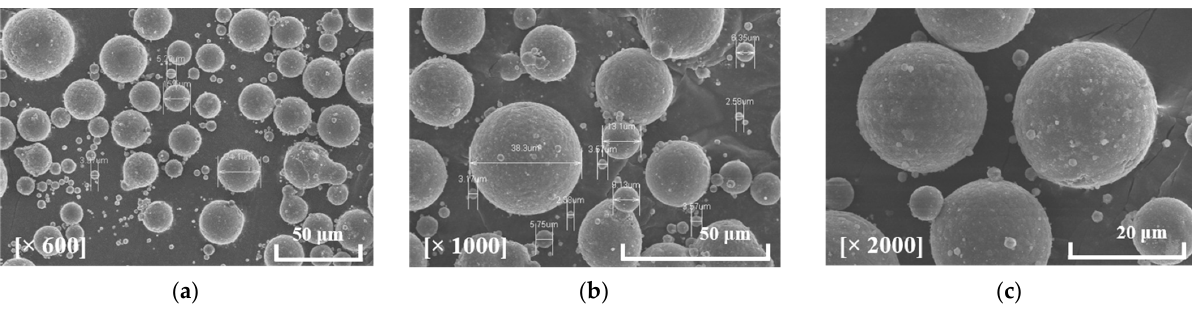
Figure 15. Original location and domain of extracted sample parts from the entire heat exchanger domain.